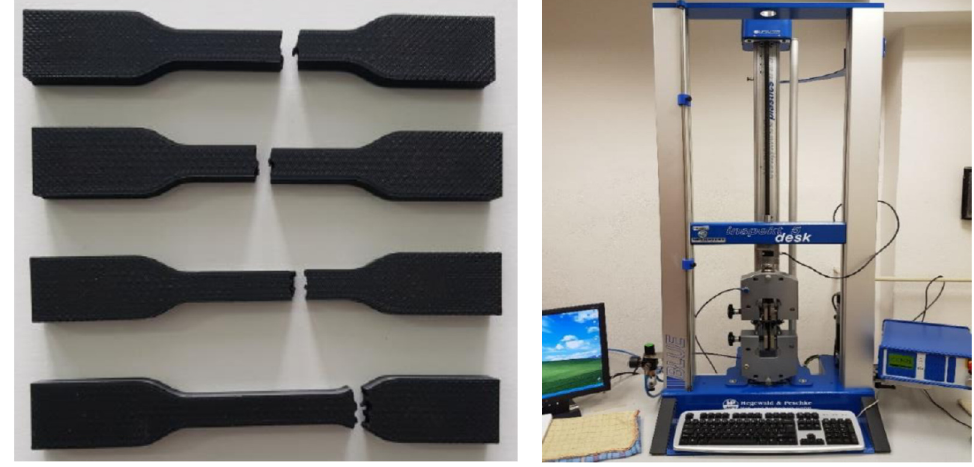
Figure 4. Specimens and testing device for experiment.